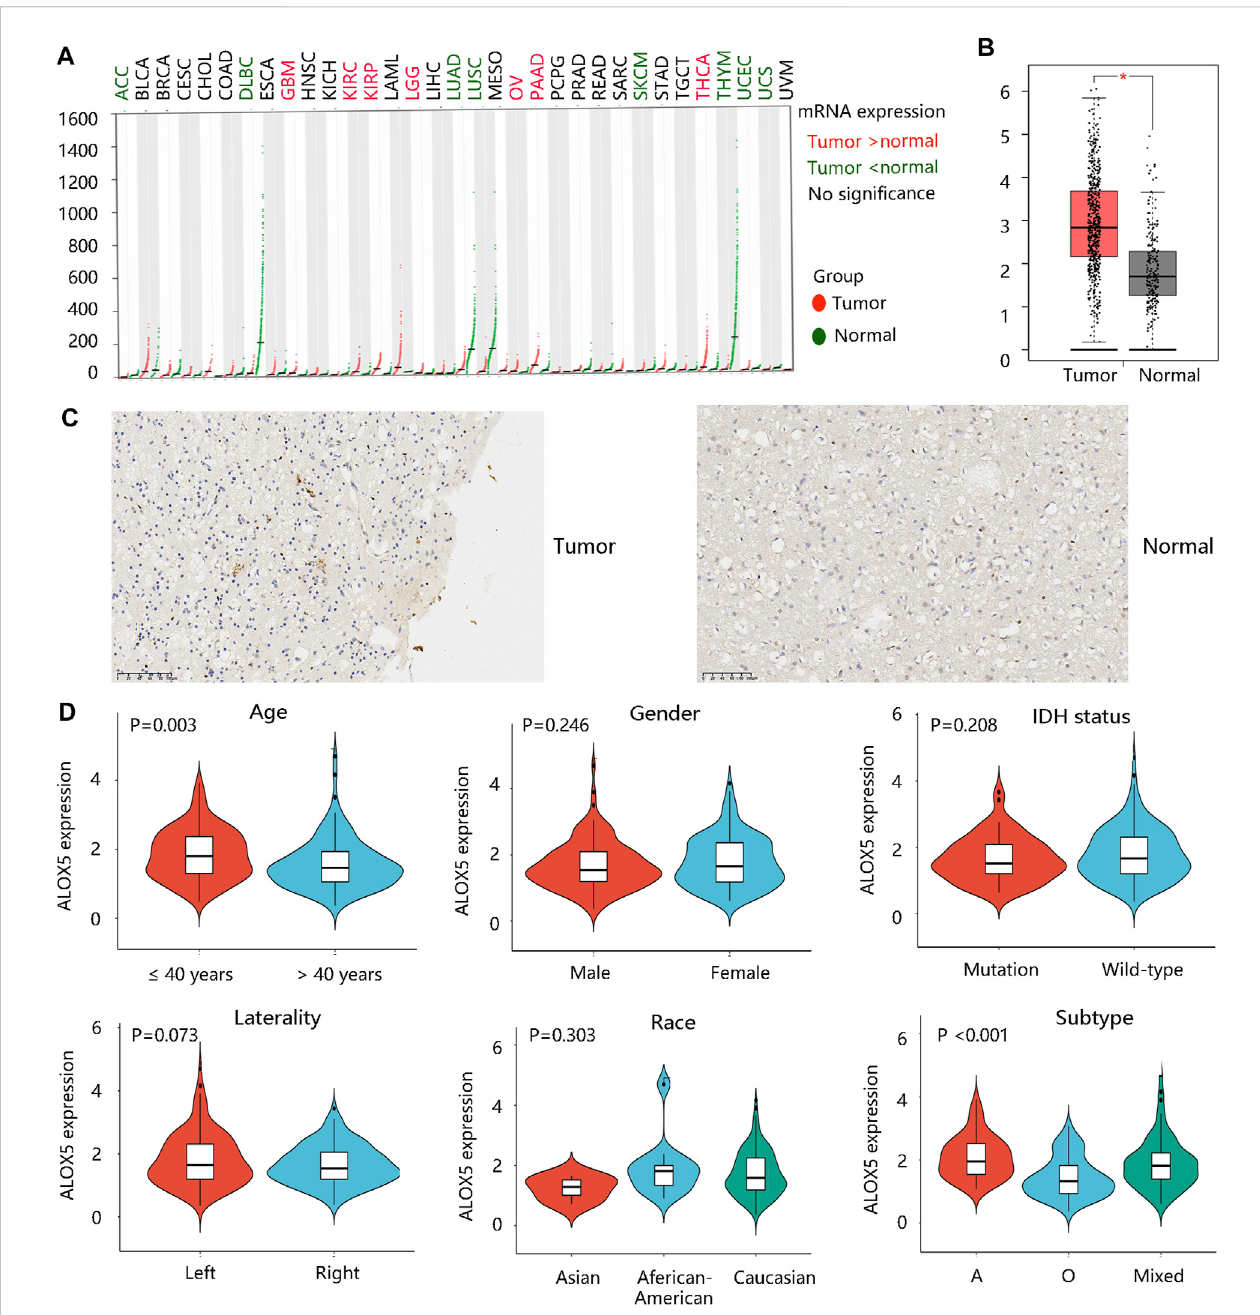
FIGURE 1 ALOX5 gene expression pro fi le. (A) The ALOX5 gene expression in various cancers. (B) The higher ALOX5 expression in low grade glioma (LGG). (C) The protein level of ALOX5 in LGG and normal tissues by immunohistochemistry analysis. (D) The correlation between ALOX5 expression and clinicopathological